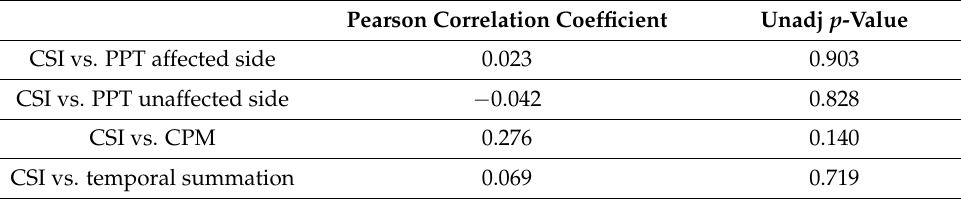
Table 3. Correlations between CSI and signs of altered central pain processing in patients with CTS.